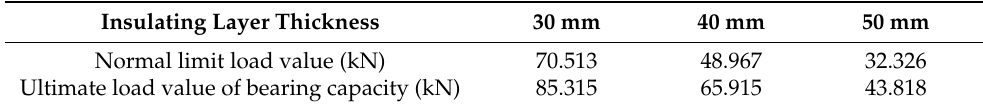
Table 10. Ultimate load under different insulation